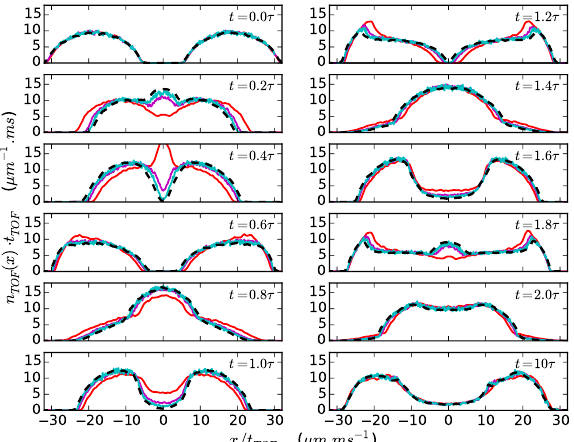
Figure 3: Density profile after Time-Of-Flight t monic trap with the same parameters as in Figs. 1-2. We compare the profiles for = 10ms (red), t = 25ms (magenta), t t TOF TOF (dashed black, corresponding to Eq.